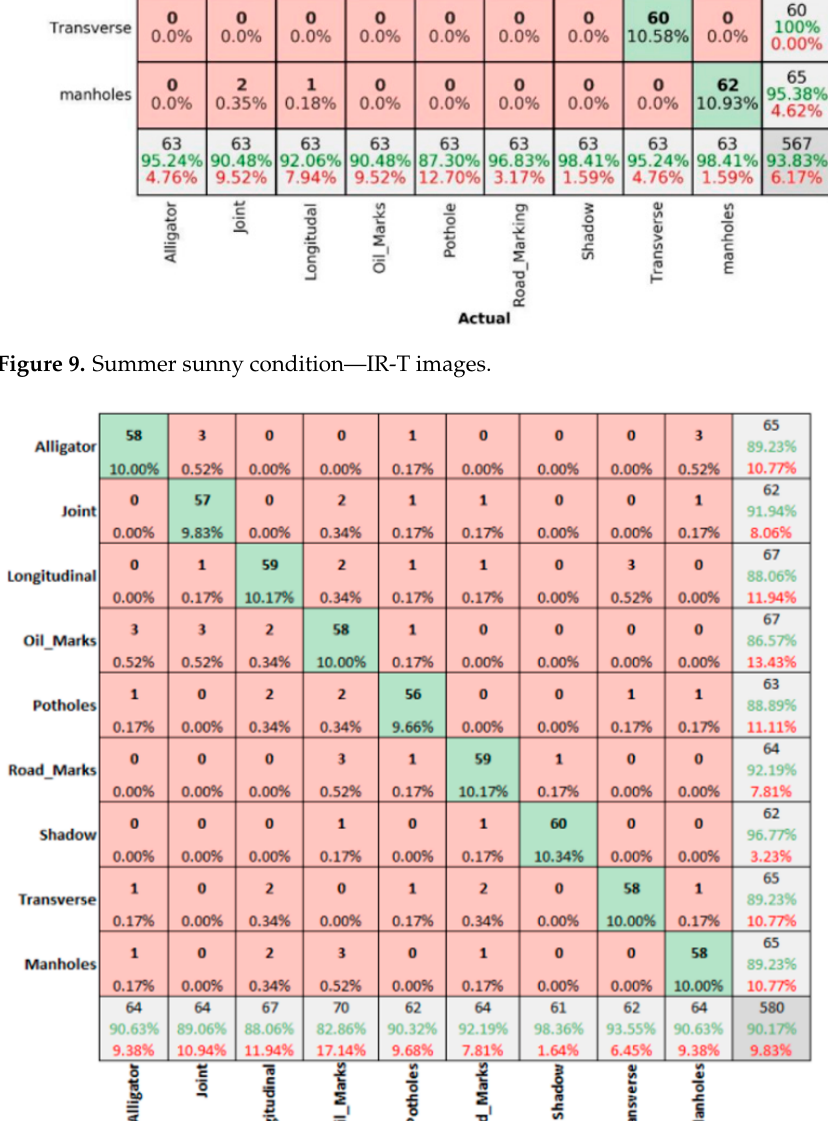
Figure 11. Summer sunny condition—MSX images.